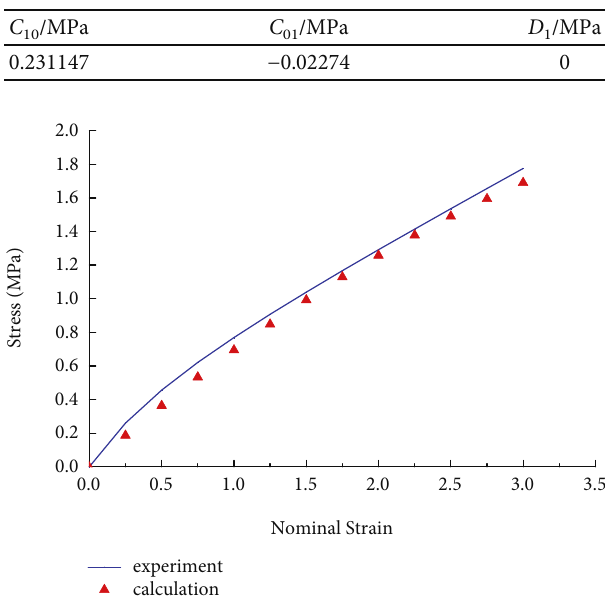
Figure 10: Mooney – Rivlin material parameters fi tting curve.